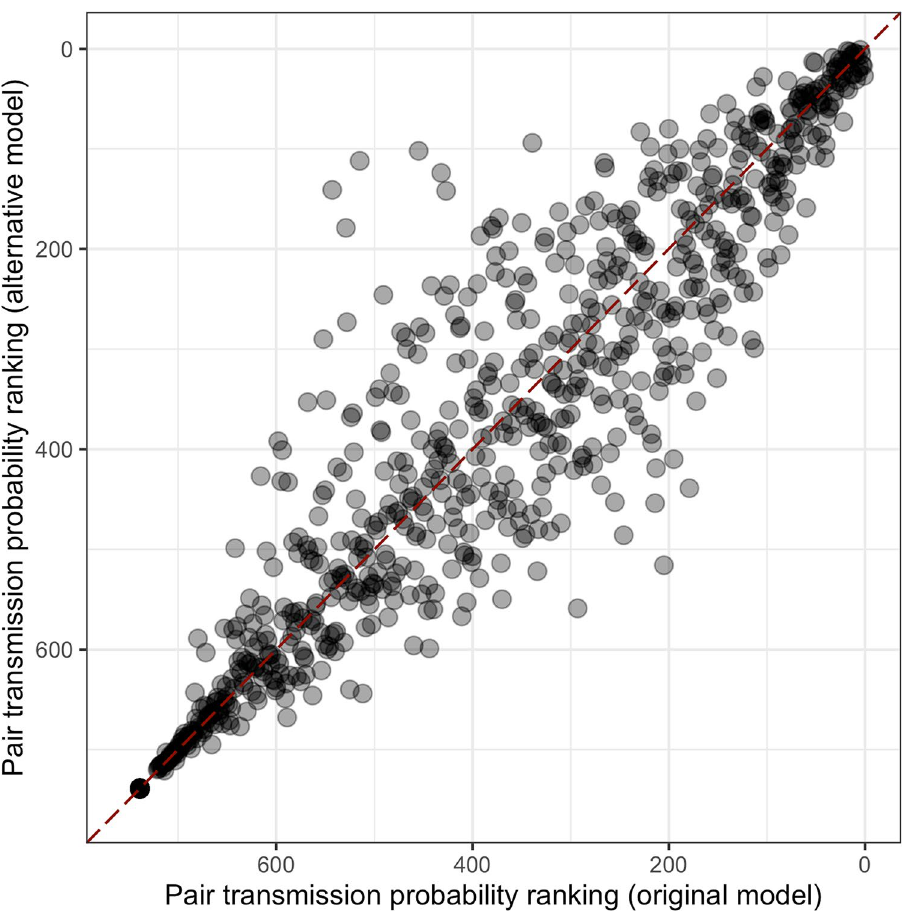
Figure 4. Transmission probabilities ranking with different bottleneck assumption. Comparison of the pairwise transmission probabilities ranking for each hosts pair using the original model (SNPs substitution allowed during the exposed stage, pathogen population bottleneck at infection) and an alternative within-host model (SNPs substitution allowed at infectious stage: pathogen population bottleneck after latent